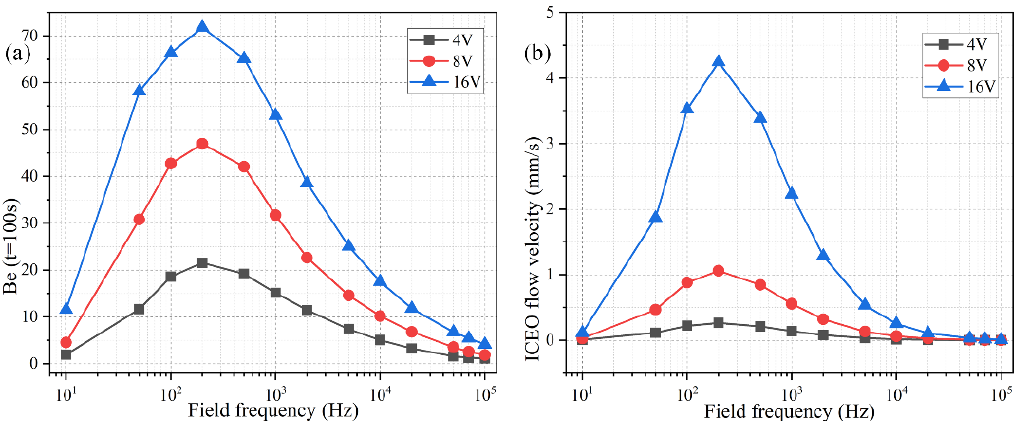
Figure 7. E ff ect of the AC signal frequency on the binding reaction with Da = 1000. ( a ) A data point plot of the binding enhancement factor Be versus AC signals of varying oscillation frequencies when the voltage amplitude takes the value of V 0 = 4 V, 8 V, and 16 V, respectively. ( b ) ROT-ICEO slipping velocity as a function of the field frequency for distinct voltage amplitude.